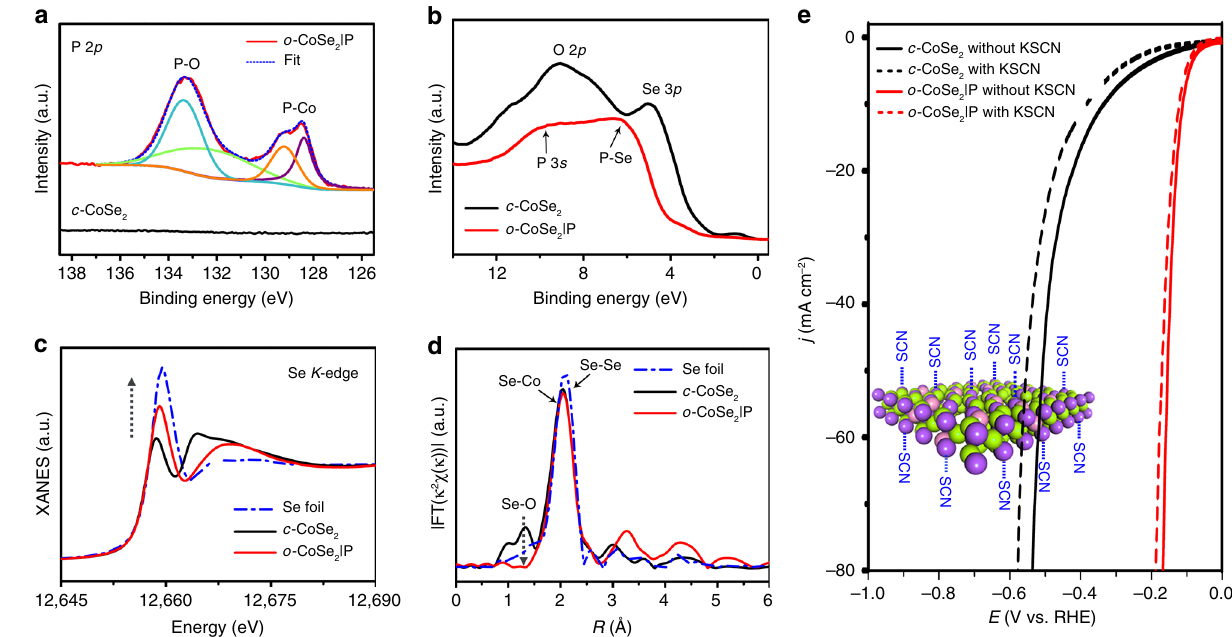
Fig. 4 Comparison of surface structure of CoSe 2 before and after P-doping. a , b P 2 p XPS spectra and valence band edge XPS spectra of c- CoSe 2 and o - CoSe 2 |P catalysts, respectively. c , d Se K -edge X-ray absorption near-edge spectra and corresponding k 2 -weighted Fourier transforms spectra for c- CoSe 2 , Se foil, and o -CoSe 2 |P catalysts. e Comparison of SCN − ions effects on the HER activities of c- CoSe 2 and o -CoSe 2 |P, respectively. Inset shows the schematic of Co centers blocked by the SCN −